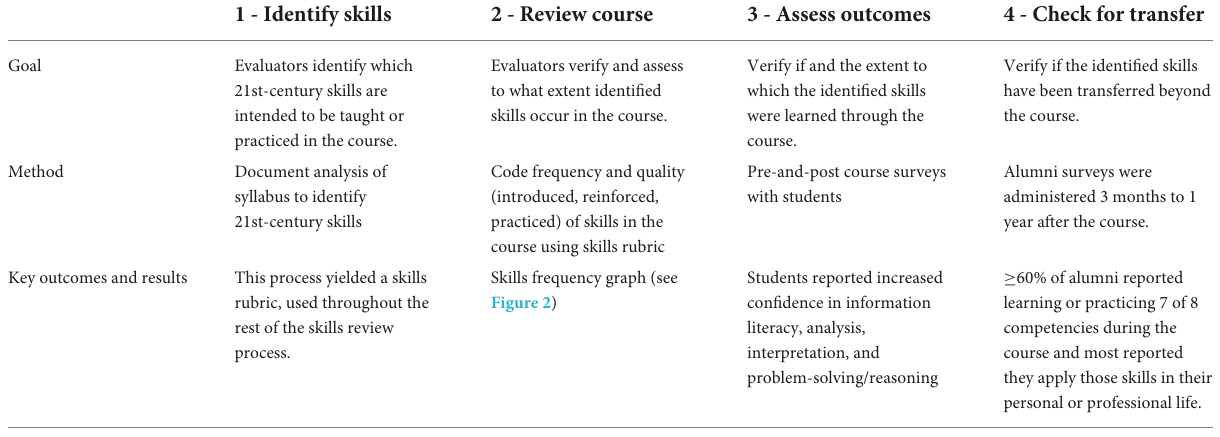
TABLE 2 Habitable Worlds assessment process using the CAST